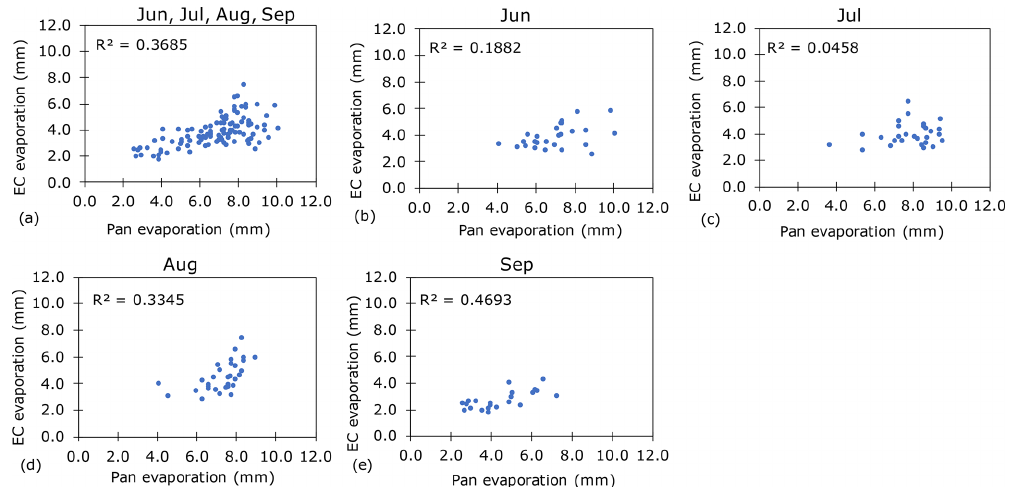
Figure 7. Correlation between the daily EC evaporation ( E EC ) and the daily pan evaporation ( E pan ): (a) June to September 2014; (b) June 2014; (c) July 2014; (d) August 2014; (e) September 2014.